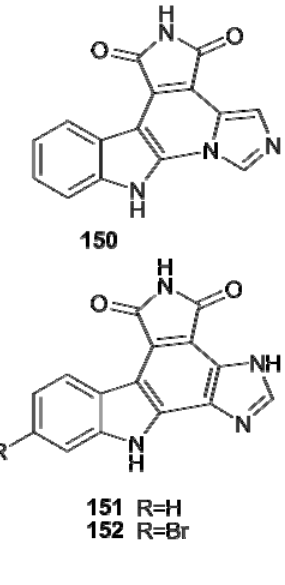
Figure 18. Bisindole